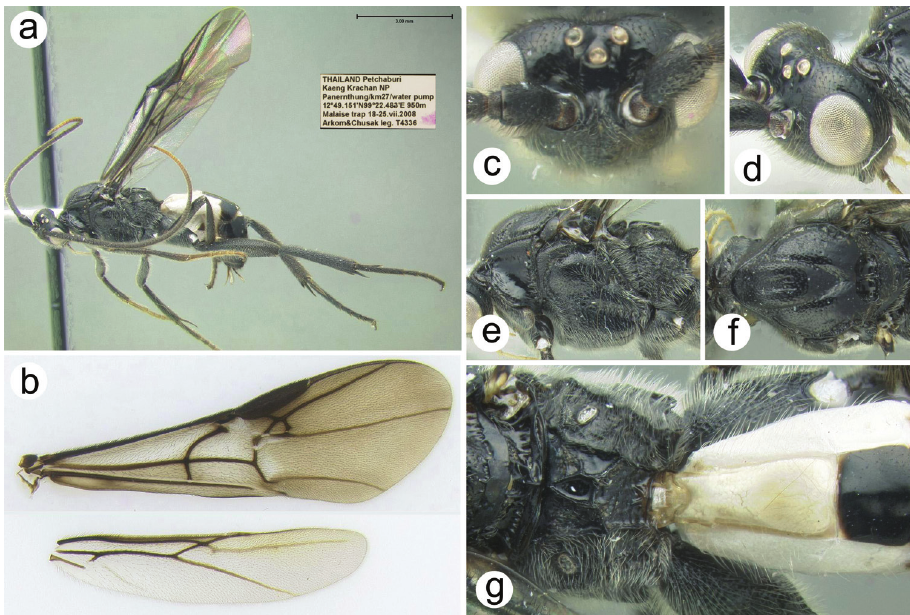
Zelodia suyaneeae Sharkey sp.n. urn:lsid:zoobank.org:act:5B1641DD-9A03-4B56-B7B7-8A1749AE17FE http://species-id.net/wiki/Zelodia_suyaneeae Fig. 17 Diagnosis. Hind femur all pale; mesoscutum entirely pale; hind tibia mostly pale ex- cept apex and sometimes extreme base black; stigma partly or entirely yellow; median ocellus distinctly narrower than space between lateral ocelli; lateral surface of hind femur sparsely punctate, spaces between punctures wider than diameter of punctures. Description. Body length 5.7 mm (5.7–6.4). Head. 40 (40–45) flagellomeres. Median ocellus diameter narrower than space between lateral ocelli. Vertex sparsely and weakly punctate. Mesosoma. Notauli partly smooth, otherwise with weak punctures. Metapleuron sparsely covered with setae. Fore wing cells hyaline basally, weakly infuscate apically, veins yellow basally, melanic apically and around parastigma, stigma yellow in basal third. Hind tarsal claw bifid. Length/ width of hind femur 1.856/0.531 = 3.5 (3.4–4.4). Lateral surface of hind femur punctate. Metasoma. Length/width ratio of MT1, 0.87/0.434 = 2.0 (2.0–2.5). Ratio of widest point of MT1 to narrowest point 0.434/0.269 = 1.3 (1.3 – 1.4).